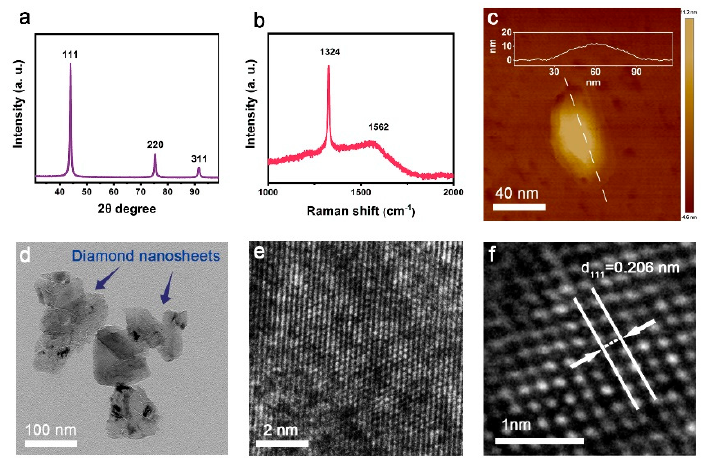
Figure 2. Characterizations of diamond nano-sheets. ( a ) XRD pattern, ( b ) Raman spectrum and ( c ) AFM morphology of diamond nano-sheets. TEM micrographs at ( d ) low and ( e ) high magnifications. ( f ) Enlarged view of the TEM micrograph in ( e ).